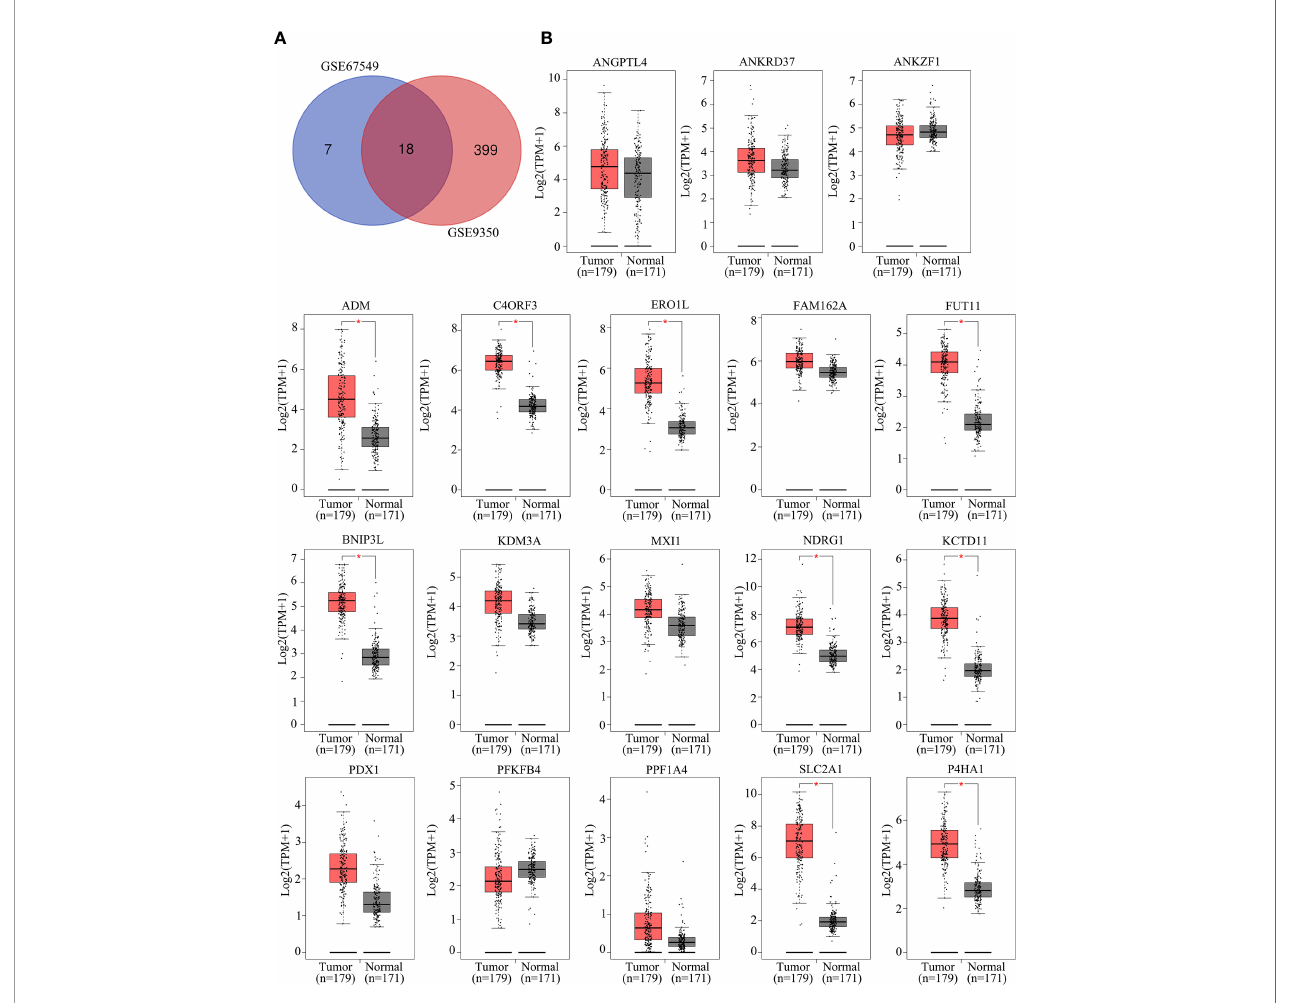
FIGURE 1 | Identi fi cation of key hypoxia-related genes in PC. (A) Intersection analysis of differentially expressed genes in PC samples under hypoxia based on the gene expression pro fi les of GSE67549 and GSE9350. (B) The mRNA expression of ANGPTL4, ANKRD37, ANKZF1, ADM, C4ORF3, ERO1L, FAM162A, FUT11, BNIP3L, KDM3A, MXI1, NDRG1, KCTD11, PDX1, PFKFB1, PPF1A4, SLC2A1 and P4HA1 in PC tissues compared with non-tumor tissues analyzed by GEPIA online